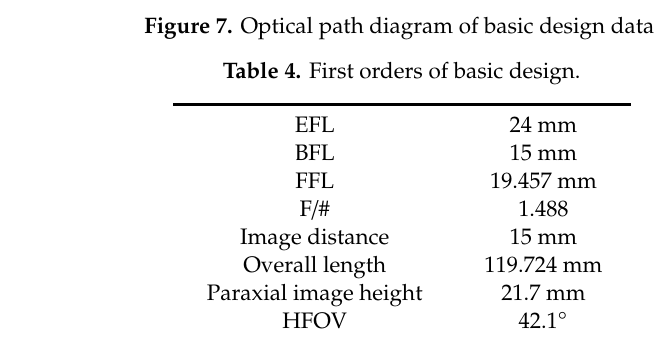
Table 4. First orders of basic design.